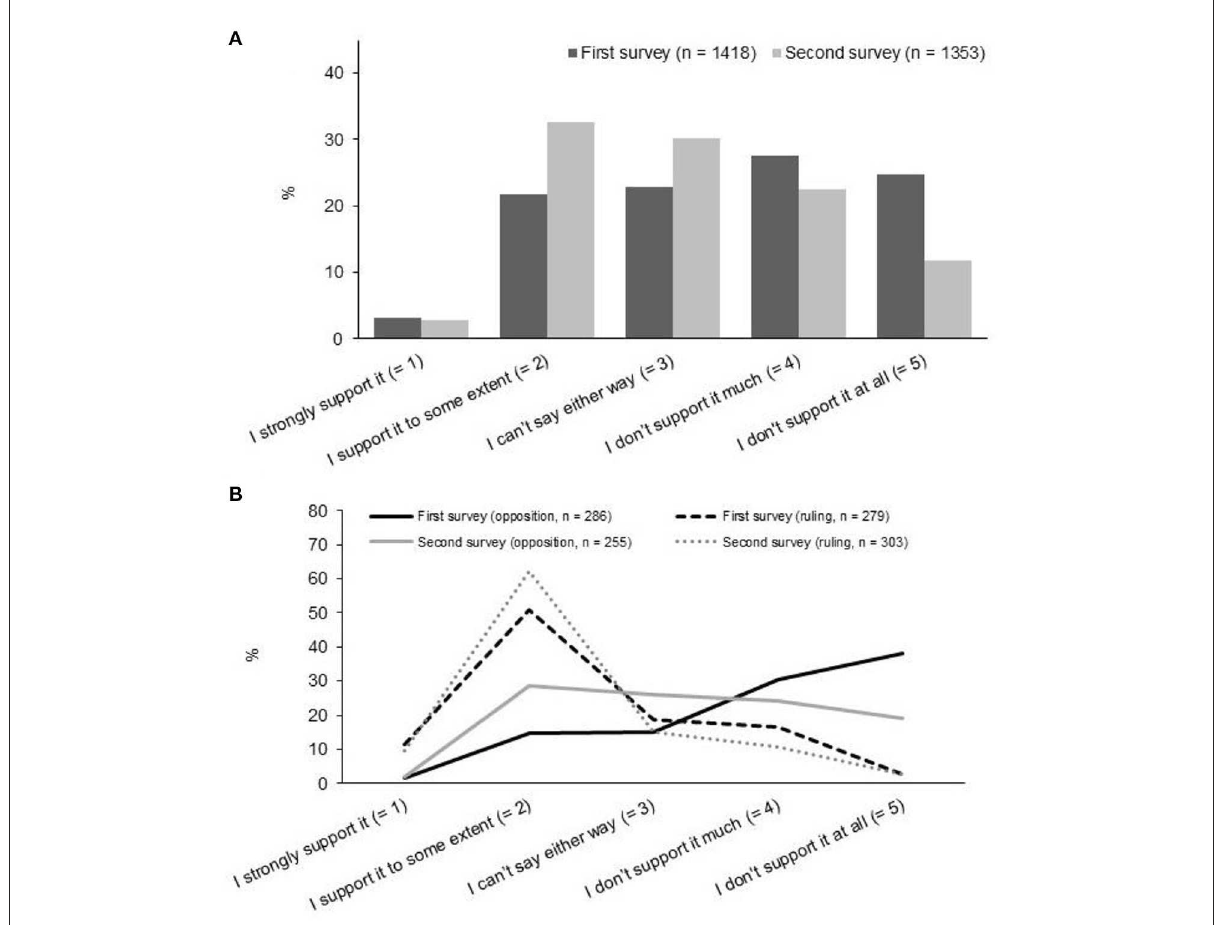
FIGURE1 (A) Level of support for the Japanese government’s approach to COVID-19 and (B) level of support for the Japanese government’s approach to COVID-19 based on support for different political